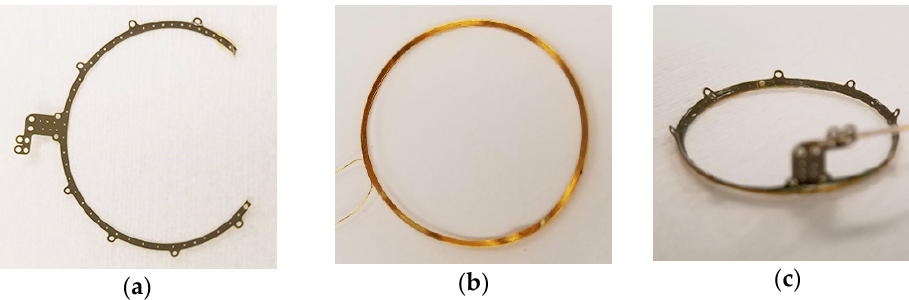
Figure 6. Microfabricated supporting structure for supporting and suturing a 19 mm diameter wire wound secondary radio frequency coil around the cornea (see also Figure 1). ( a ) A base layer of HD Microsystems PI-2611 polyimide was applied to a host Si wafer, electroplated Au was added to mechanically reinforce the structure, and the support perimeter and suture holes were etched by O 2 RIE; ( b ) An Au wire coil wound on a spherical form so that it would lay flat on the sclera surface; ( c ) The assembled coil support with an incoming silicone tube to protect the coil wires from handling and to allow flexibility of coil placement relative to the electronics package.